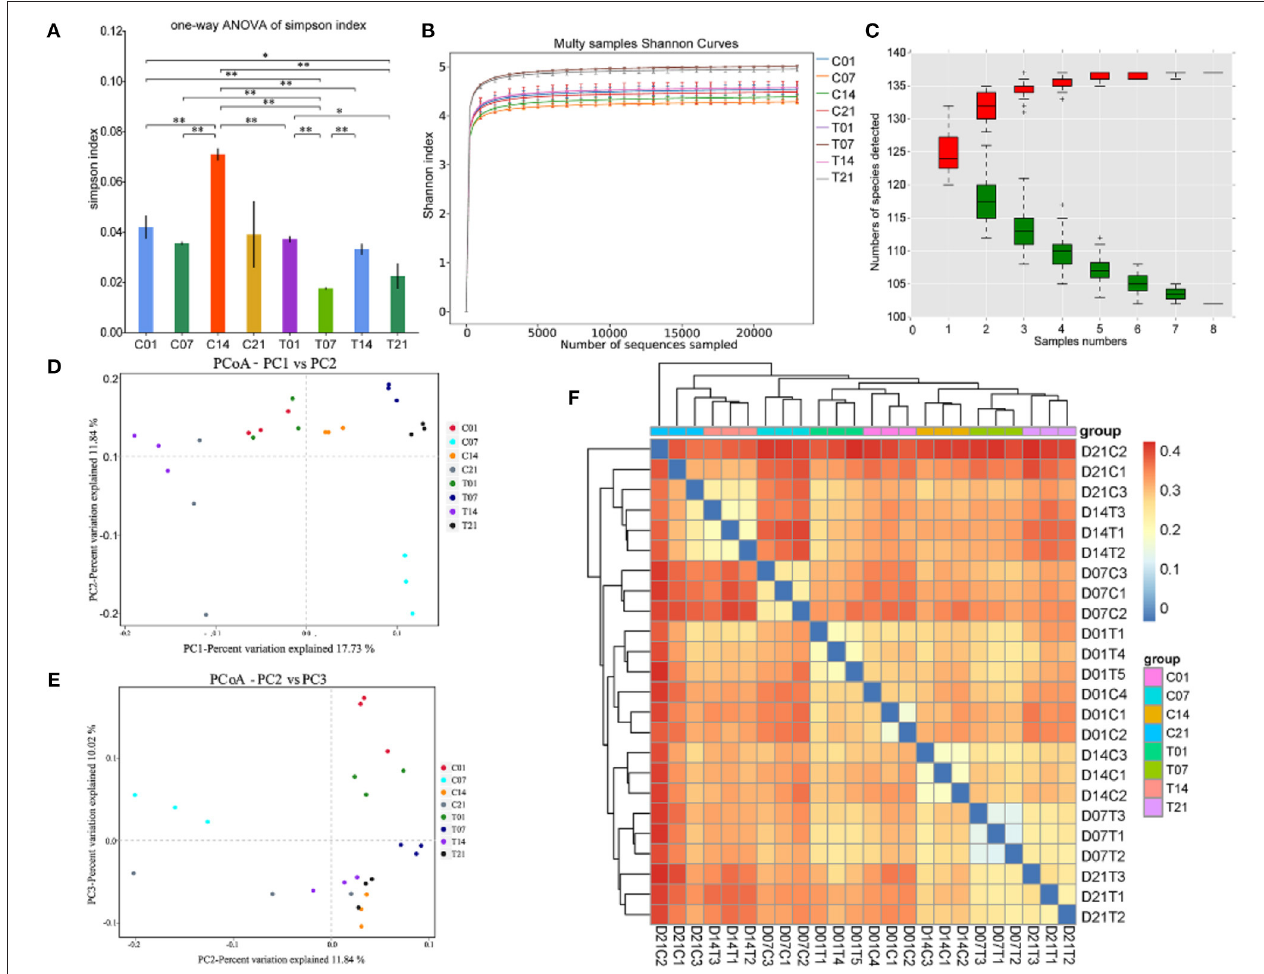
FIGURE 4 | Effects of heat stress on pig colonic microbiome. (A) Simpson Index plot; (B) Multy Shannon curves; (C) Species accumulation curves; (D,E) Principle component analysis (PCoA); (F) Heatmap of sample distance. C and T refer to control- and HS pigs, respectively; 1, 7, 14, and 21 refer to sampling days of pig feces. * P < 0.05, ** P < 0.01 compared with each